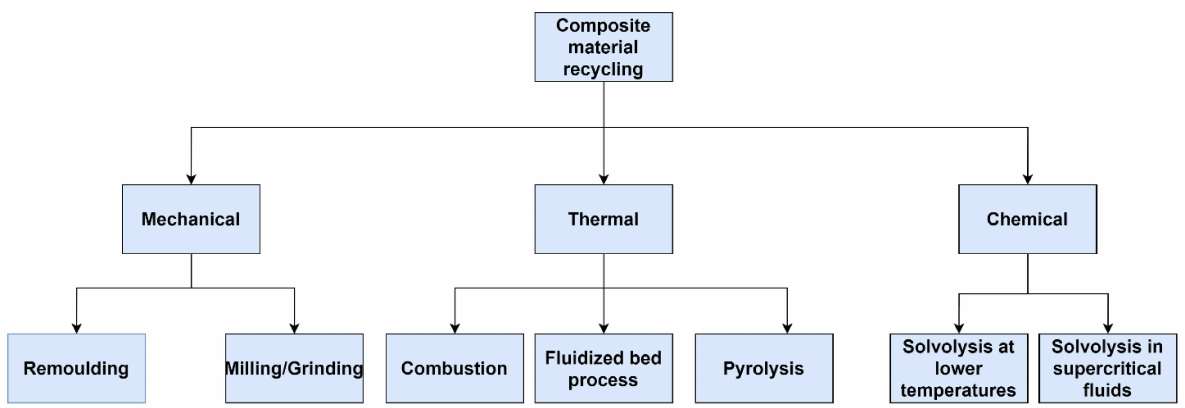
Figure 4. Classification of composite material recycling